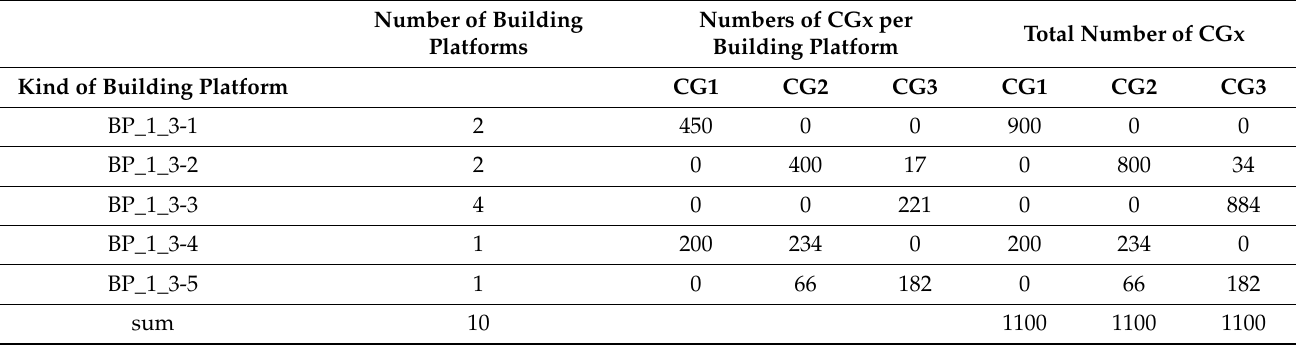
Table 5. Numbers of different types of cylinder geometries (CG) arranged on the different building platforms for problem 1–solution 3 with 1100 components per type in 10 printing